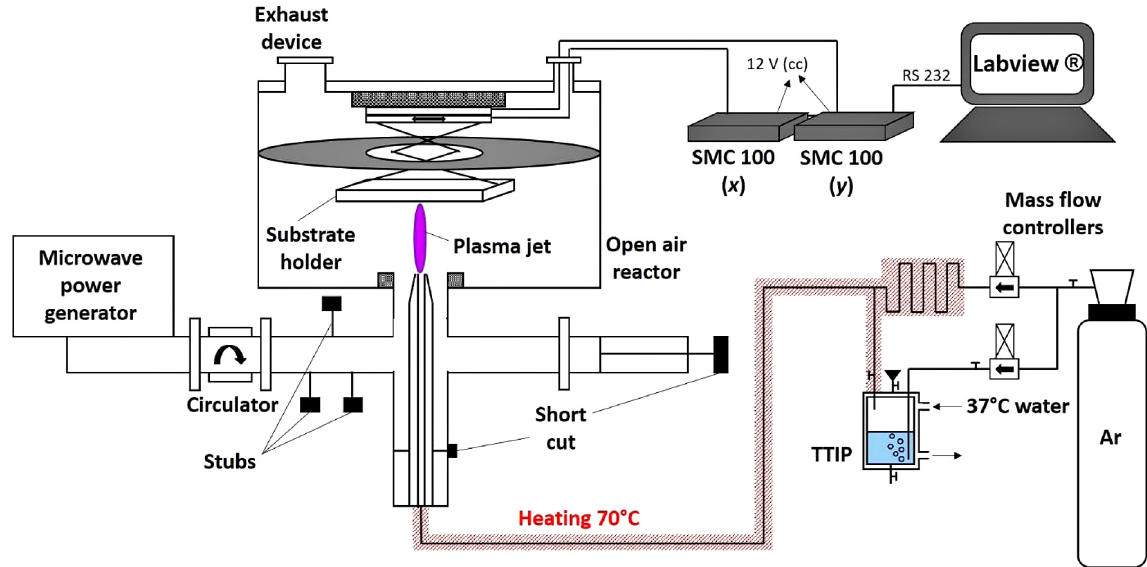
Fig. 1. Schematic representation of the AP-PECVD microwave plasma